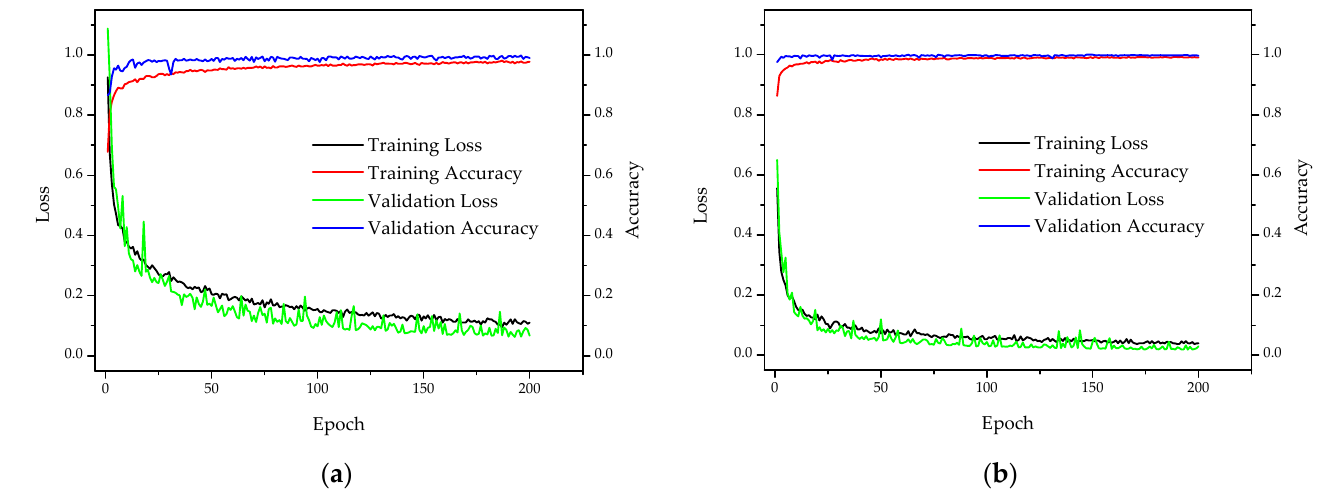
Figure 8. The classification accuracy and cross-entropy loss of the two models: ( a ) the GLNB; ( b ) the GLNB-based transfer learning model (GLNB-TL). Table 3. Comparison of the classification performance between GLNB and